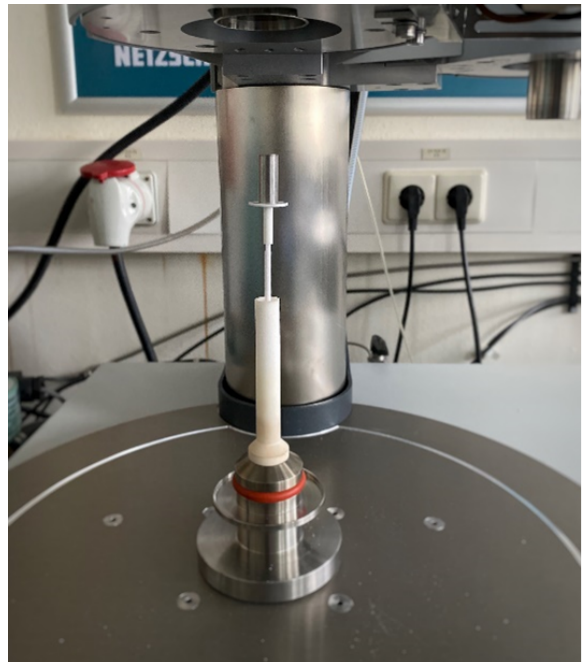
Figure 1. Specimen before exposition under high temperature steam oxidation